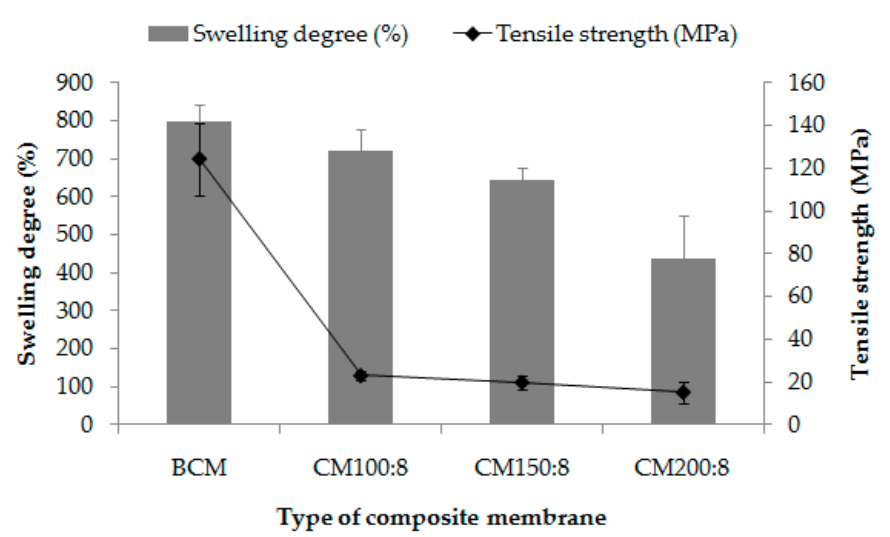
Figure 3. Swelling degree (%) and tensile strength (MPa) of composite membranes containing different amounts of curcumin (CM100:8, CM150:8, and CM200:8) compared with the blank composite membrane (BCM).